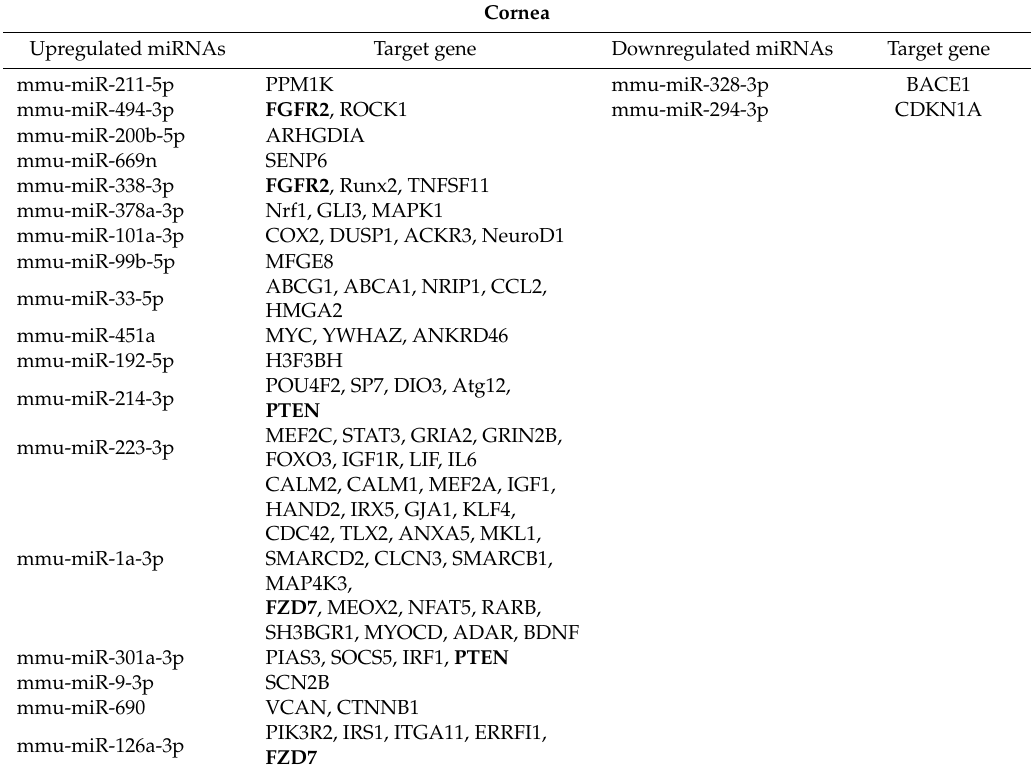
Table 8. The target genes predicted from the change in miRNA expression in the cornea.